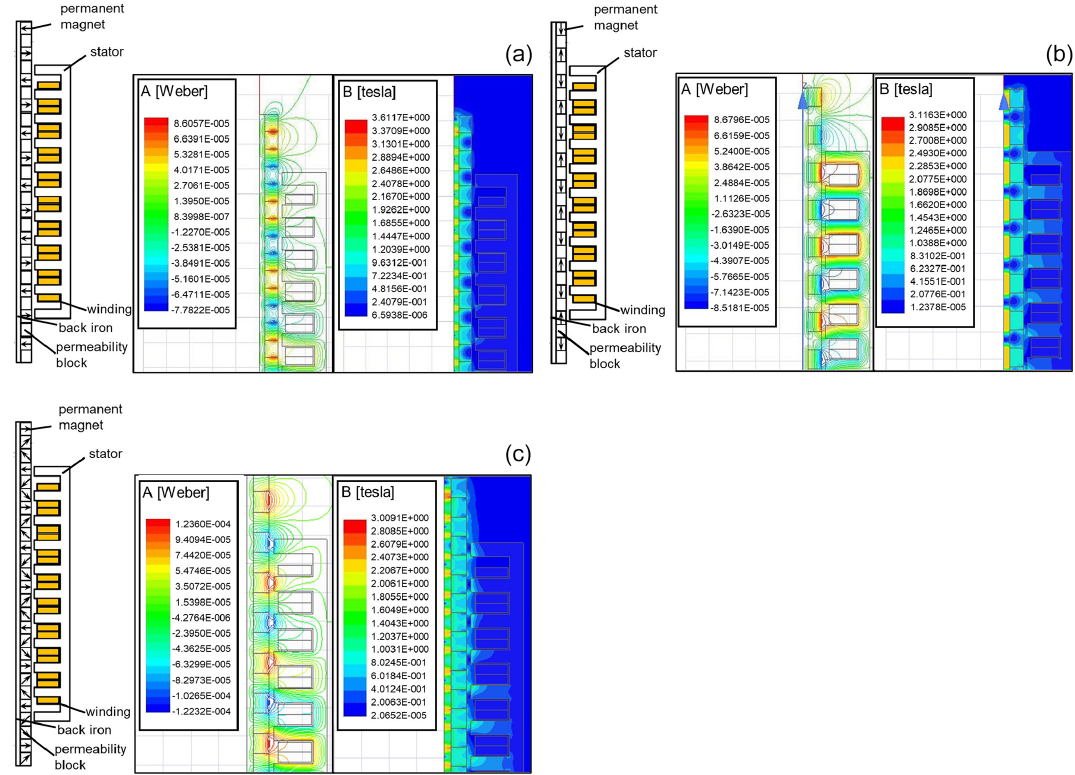
Figure 8. Magnetic flux lines and flux density: (a) radial magnetization, (b) axil magnetization, and (c) Halbach